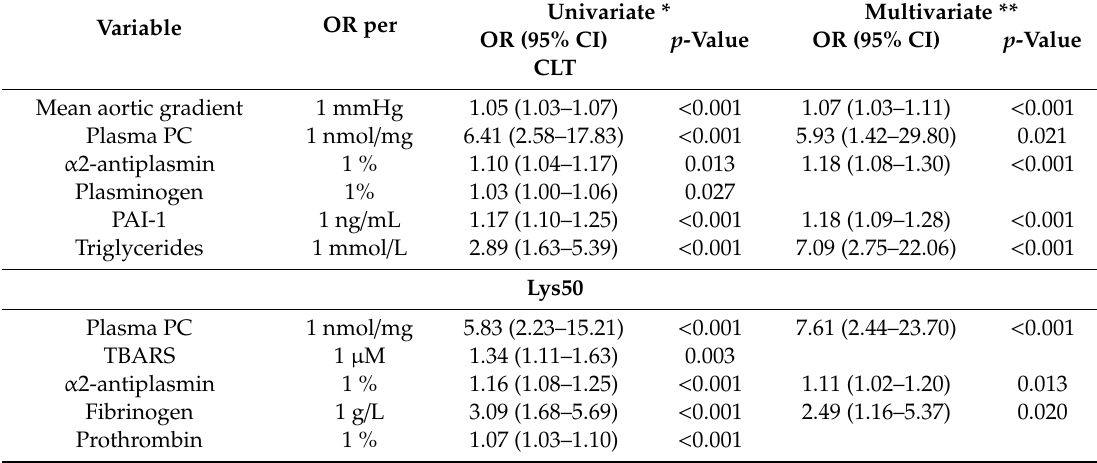
Table 3. Predictors of prolonged clot lysis time (CLT) and lysis time (Lys50) defined as the top quartile ( ≥ 104 min and > 565 s, respectively) in aortic stenosis